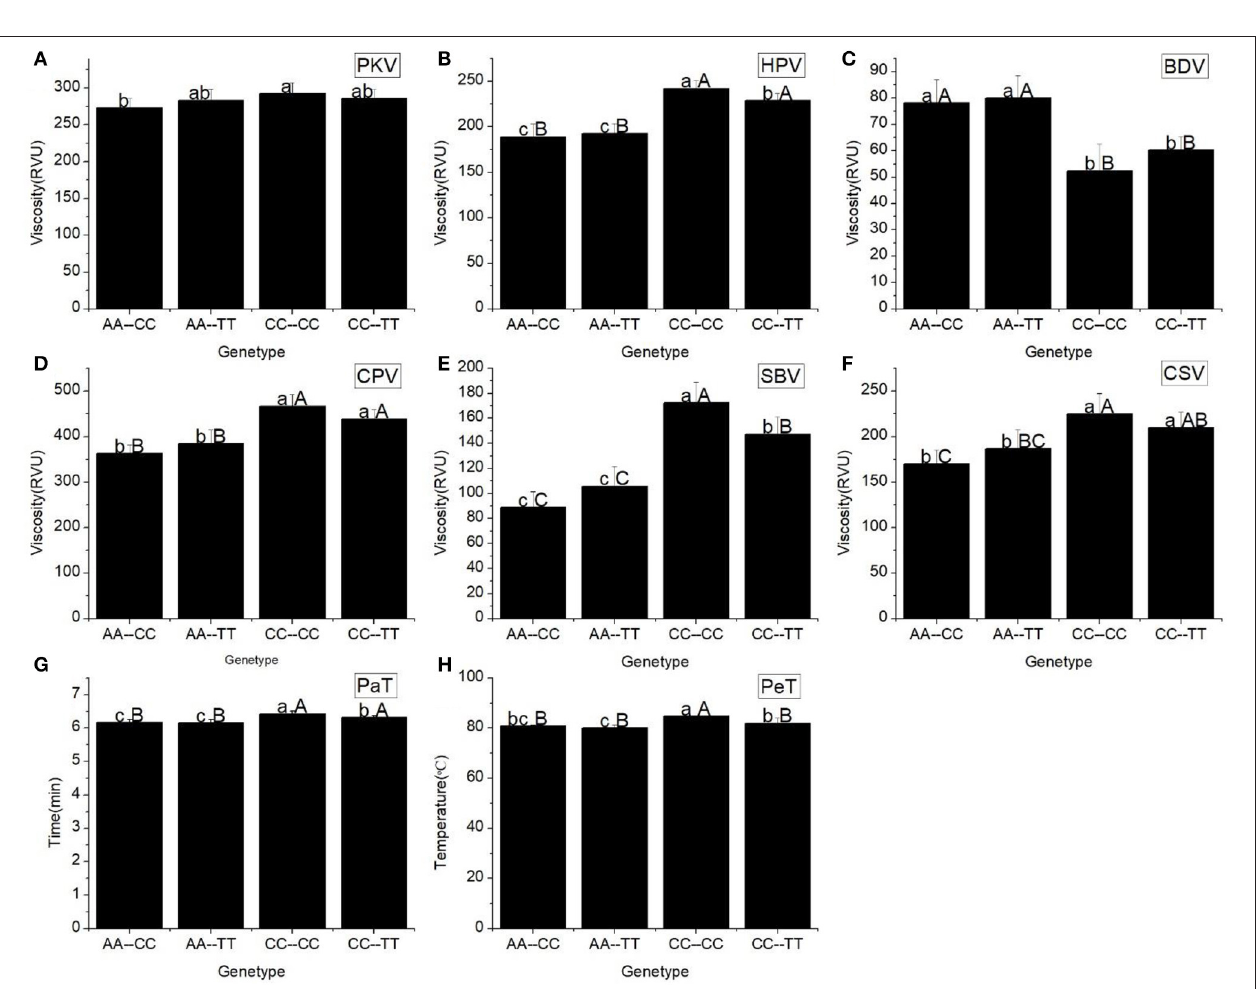
FIGURE 3 | RVA profile characteristics for different haplotypes of Ex6A/C and Ex10C/T polymorphisms of Wx . (A) Peak viscosity (PKV). (B) Hot paste viscosity (HPV). (C) Cool paste viscosity (CPV). (D) Breakdown valve (BDV). (E) Setback valve (SBV). (F) Consistency valve (CSV). (G) Pasting temperature (PaT). (H) Pasting time (PeT). AA-CC, AA-TT, CC-CC and CC-TT represent different haplotypes of Ex6A/C and Ex10C/T polymorphisms of Wx . Lowercase and capital letters above column denote significant at 0.05 and 0.01 levels,